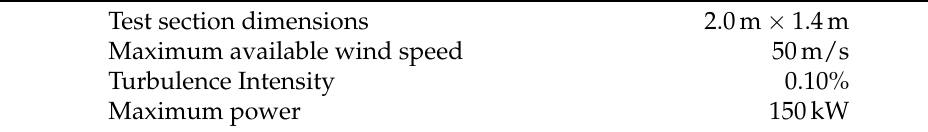
Figure 3. Main subsonic wind tunnel of the DII. Units in meters. Table 1. Wind tunnel of the DII, main